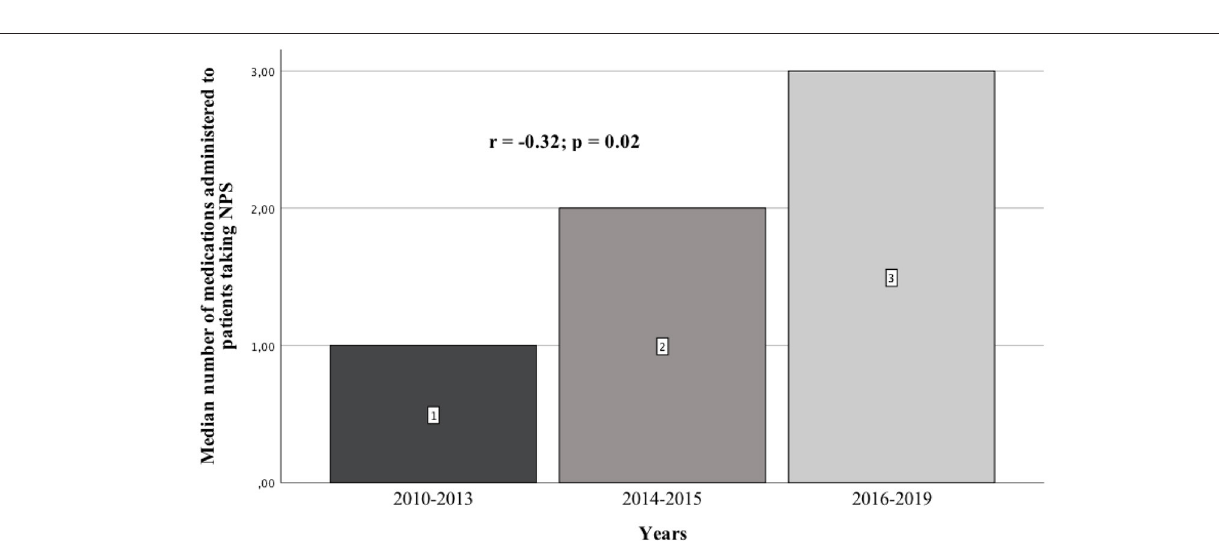
FIGURE 3 | Median number of medications administered to patients taking